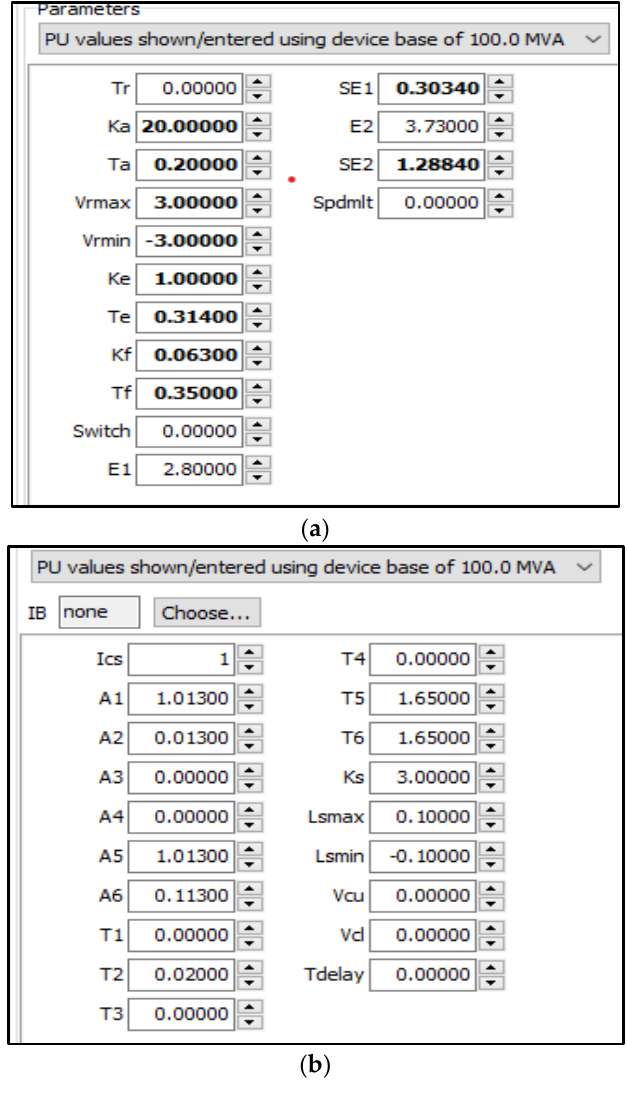
Figure 3 . Line and generator data: ( a ) exciter input statistics and configuration; ( b ) machine stabilizer input statistics and configuration.